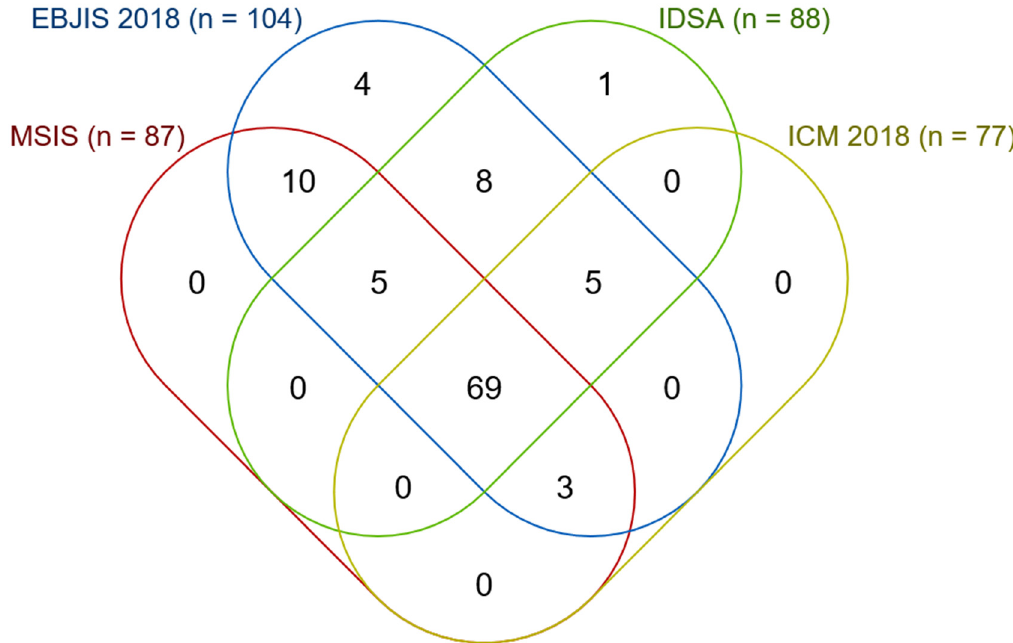
Figure 2. Venn diagram (n = 124) demonstrating the overlap of patients diagnosed according to MSIS, EBJIS 2018, IDSA and ICM